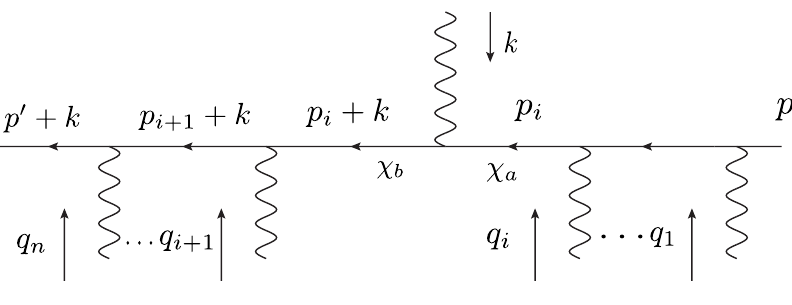
Figure 10 . The same as one of the key (cid:12)gure appeared in ref. [128]. Here the polarization vector of the photon with the symbol of its momentum \ k " will replaced by this